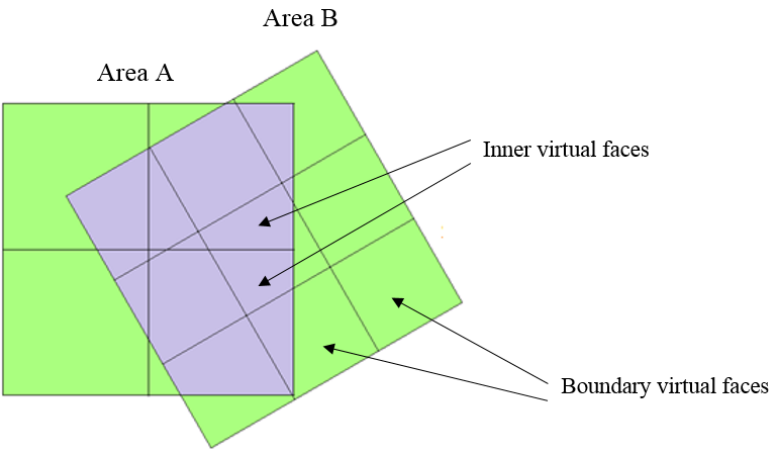
Figure 4. Creation of the virtual faces on the unmatched interface.